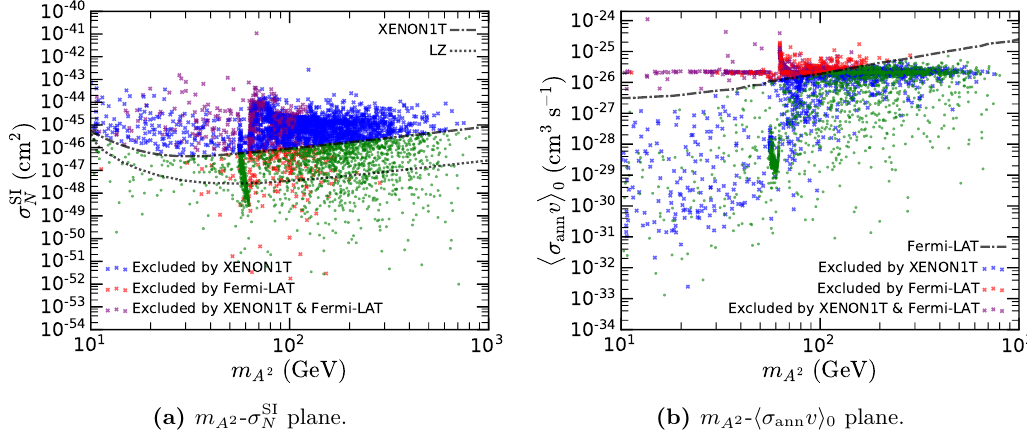
- σ SI (a) and m - h σ ann v i 0 (b) planes. In the A 2 A 2 N from XENON1T [63], while N